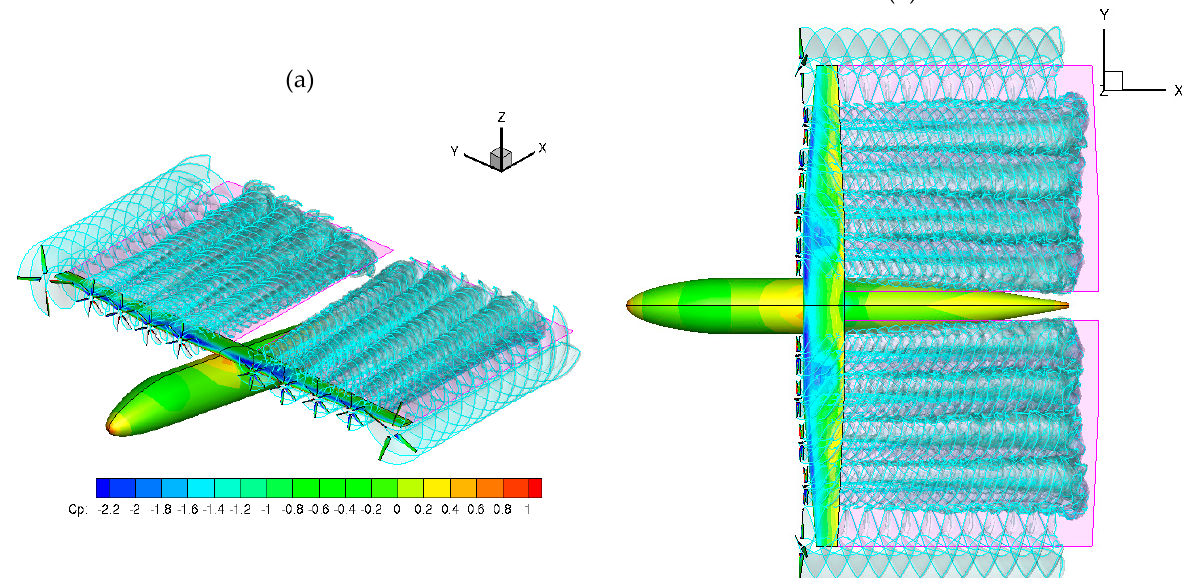
Figure 15. Motorization 2—Cp distribution and wake development in a 100%-ETR climb, isometric view ( a ) and view from above the aircraft ( b ).